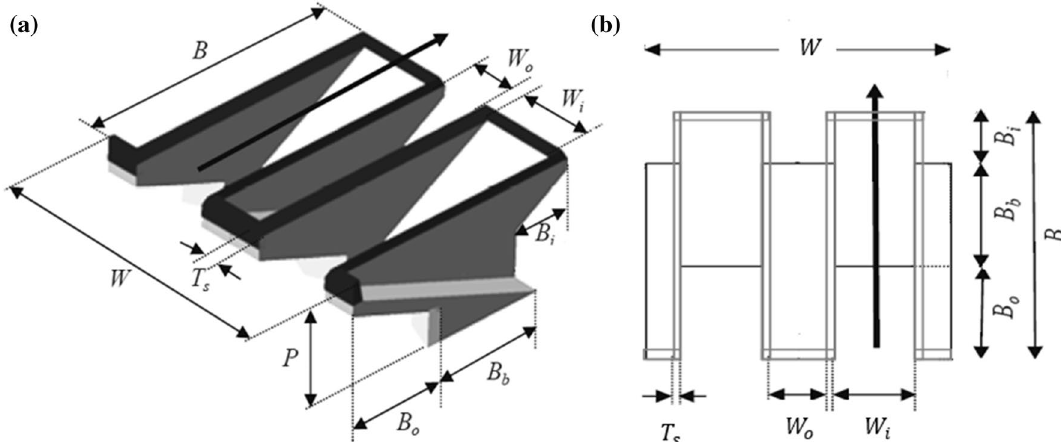
Fig. 3 General view of geometrical dimensions of rectangular PKW (Pralong et al.